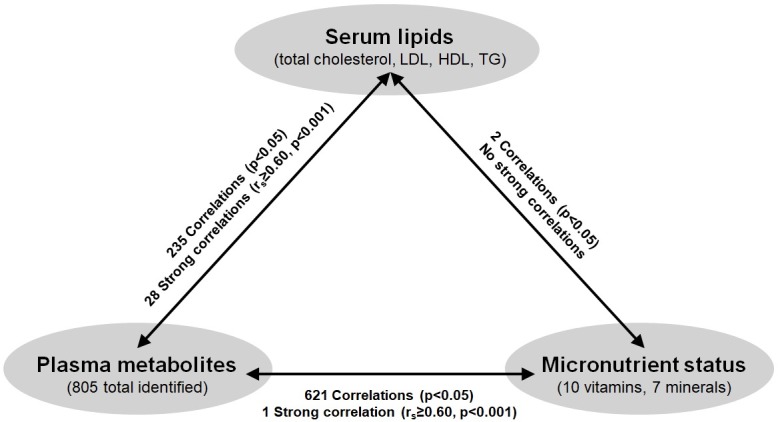
Correlations between serum lipids, plasma metabolite profiles, and micronutrient status.Spearman’s rank-order correlations were performed and significance set at p<0.05 with subsets of strong correlations rs≥0.60 and p<0.001. Abbreviations: LDL, low-density lipoprotein cholesterol; HDL, high-density lipoprotein cholesterol; TG, triglycerides.